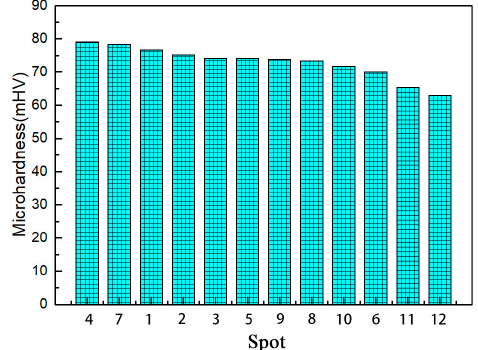
Figure 12. Microhardness of each point on the thread profile.